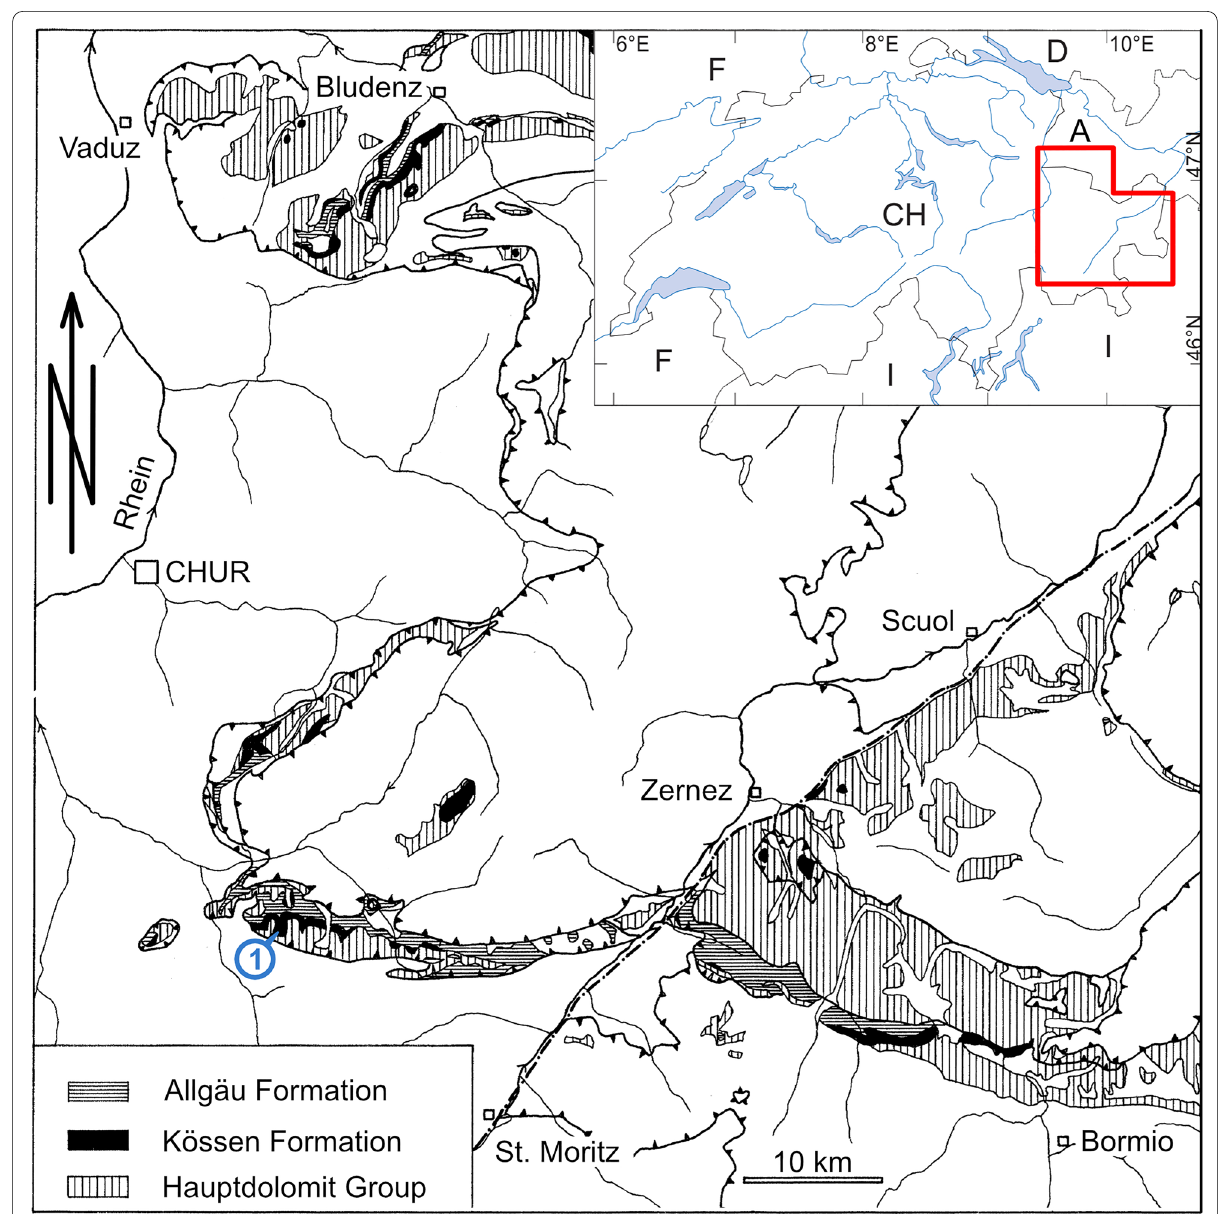
Fig. 1 Geographical map and geological context of PIMUZ A/III 5166. The specimen was found in scree (position is indicated by blue circle and a blue 1) of the Upper Triassic Kössen Formation northwest of the mountain Piz Mitgel (lower Austroalpine Ela nappe). A, Austria; CH, Switzerland; D, Germany; F, France; I,